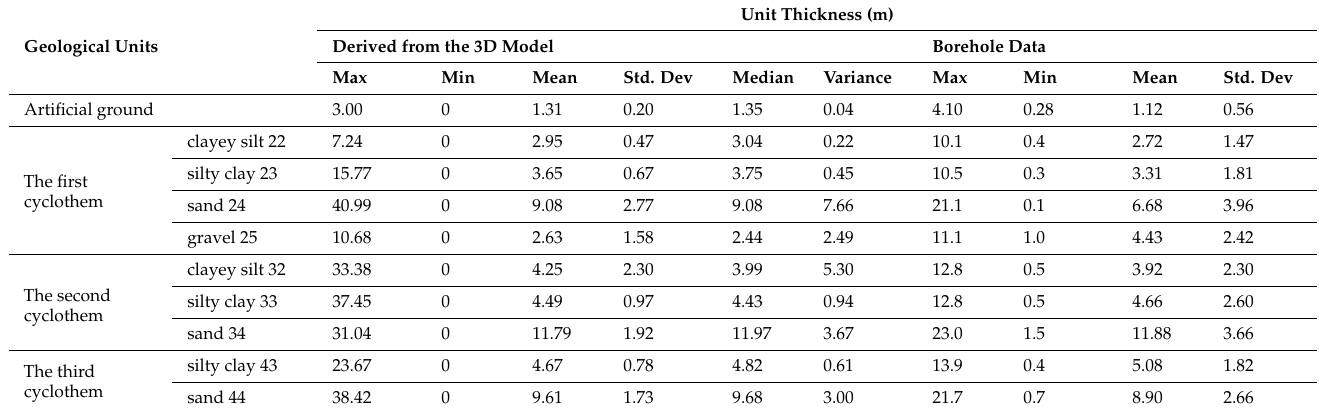
Table 1. Interpreted thicknesses of various units derived from the 3D geological model and bore- hole data.